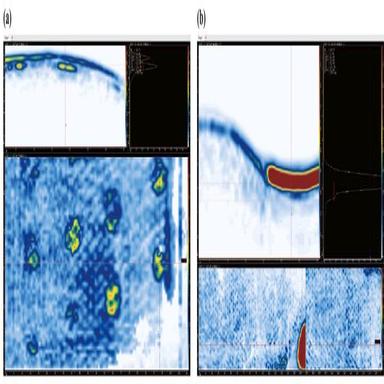
Testing results in the area of (a) box 2 and (b) box 3. Upper left is the S-scan image, upper right is the A-scan signal and lower is the C-scan image.